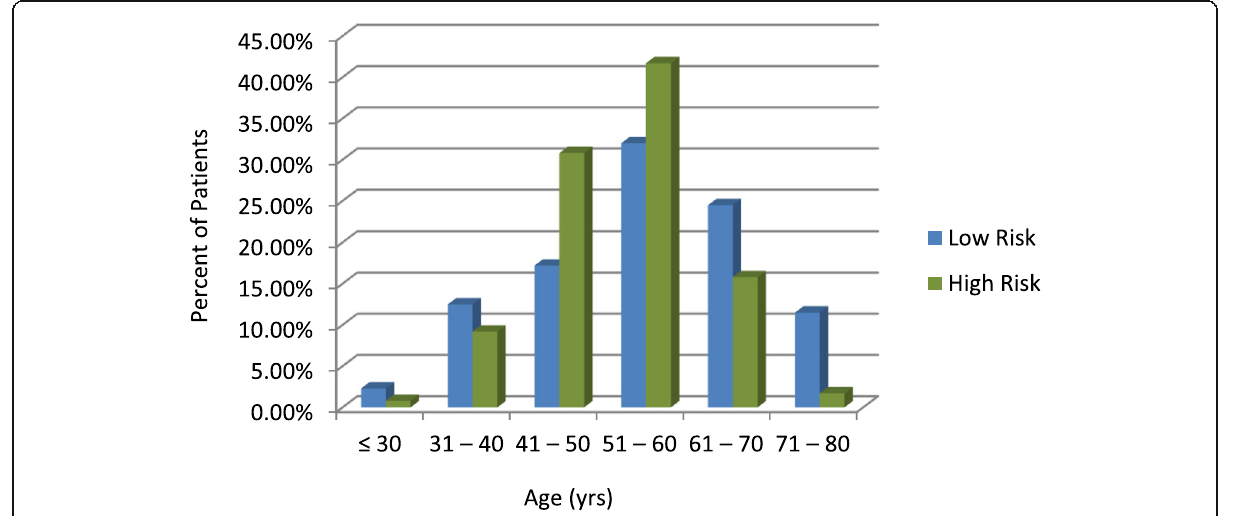
Fig. 2 Comparison between age and the risk of Obstructive Sleep Apnoea